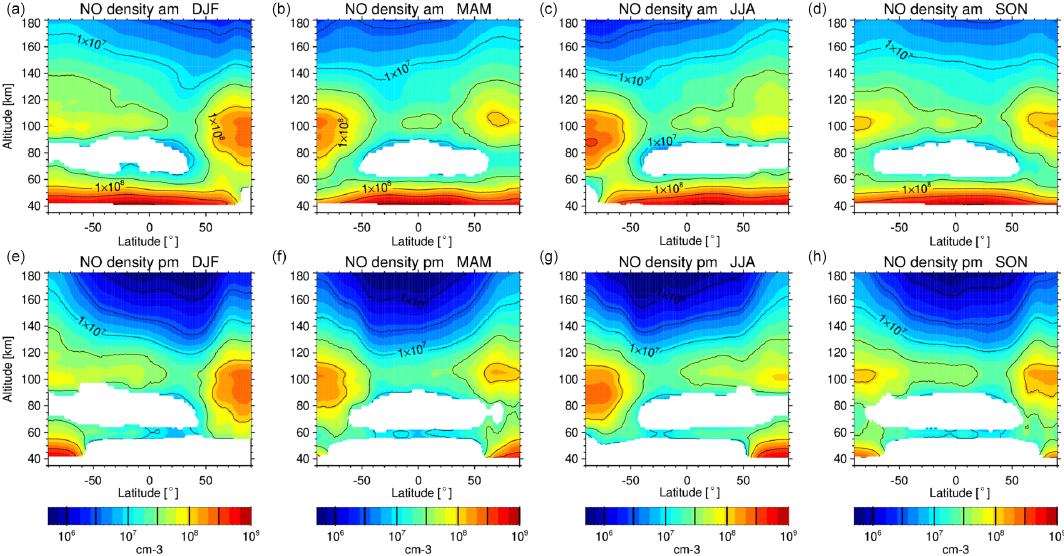
Figure 13. Seasonal composite zonal mean distributions of retrieved NO densities from UA measurements as a function of latitude and altitude, separated for (a–d) morning and (e–h) afternoon. Left to right: DJF, MAM, JJA, SON. White areas indicate data with insignificant information content (AK diagonal <